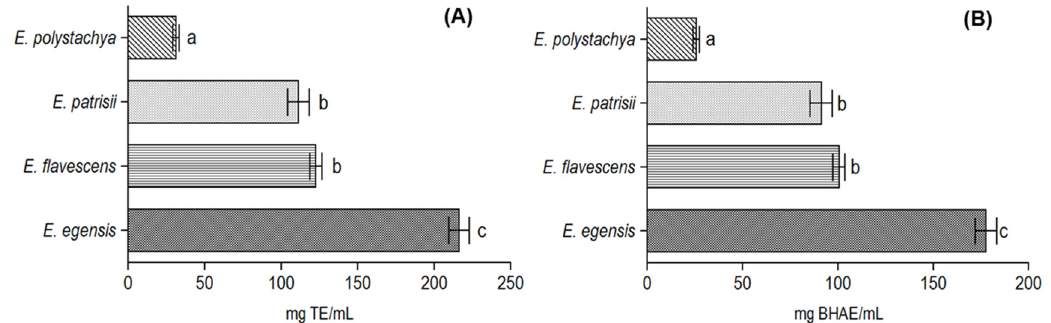
Figure 1. Antioxidant activity of the Eugenia oils by the DPPH assay. Results expressed in milligrams of Trolox ( A ) and BHA ( B ) equivalent per milliliter of sample. Mean ± standard deviation ( n = 3). Values with different letters in the figure represents statistical differences at the p < 0.05 level (Tukey’s